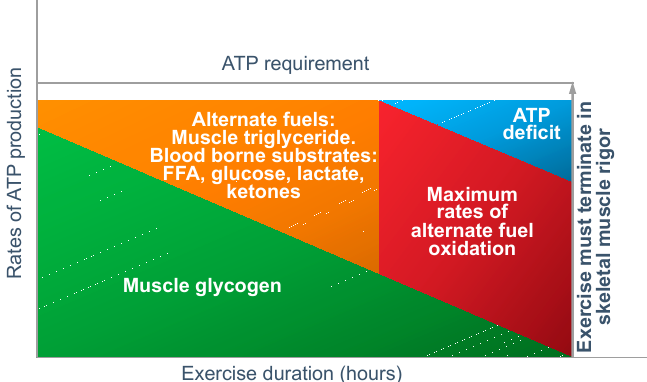
Figure 12. If an inability to generate sufficient ATP in the exercising muscles was the key factor ‘limiting’ exercise performance during prolonged exercise then, in this unregulated system, the sole outcome would always be the development of skeletal muscle rigor. Since skeletal muscle rigor does not happen during any form of exercise, skeletal muscle function (and metabolism) must be homeostatically regulated, specifically to prevent this catastrophic outcome.